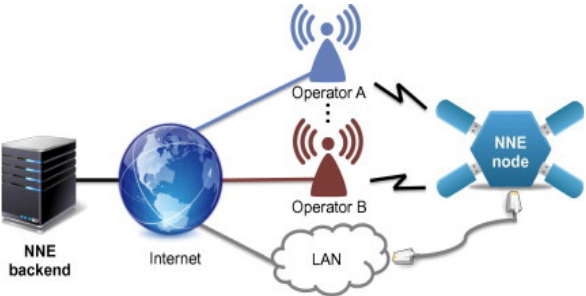
Figure 7. The overall system architecture of the NNE platform [52].